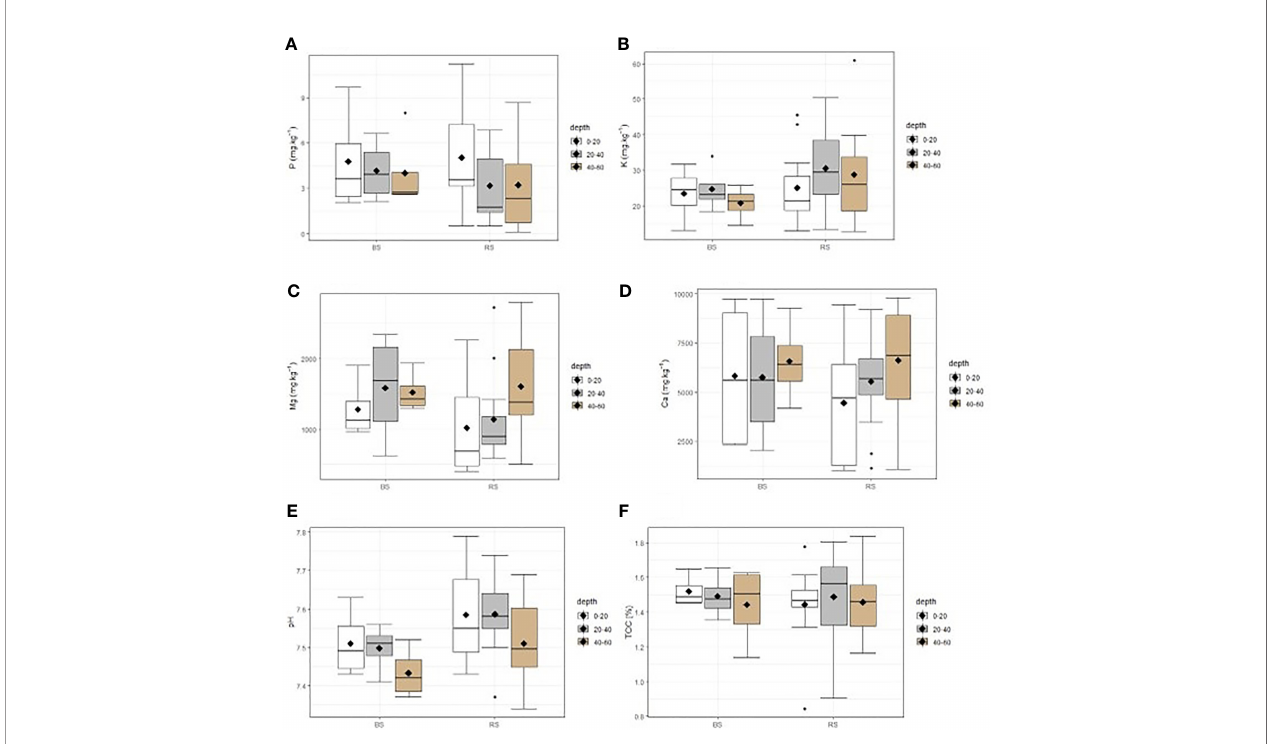
FIGURE 1 | Extractible macronutrient concentration and pH in the reclaimed soil (RS) and on the bare soil (BS) at different depth (0 – 20cm, 20 – 40cm, and 40 – 60 cm). n = 12 for RS, and n = 4 for BS. TOC, total organic carbon. (A) : P, (B) : K, (C) : Mg, (D) : Ca, (E) : pH, (F) : with four to six individuals, whereas S. guineense was only 16.6 cm. An individual was counted as juveniles when it had a represented by one individual. A. auriculiformis had the highest height from 15 to 150 cm; L. leucocephala had highest and mean height (6.7 m) and dbh (21.9 cm), and the other species had increasing number of juveniles (716 to 1,032), followed by A. the height ranging from 3.4 to 5.5 m and the dbh from 7.9 to